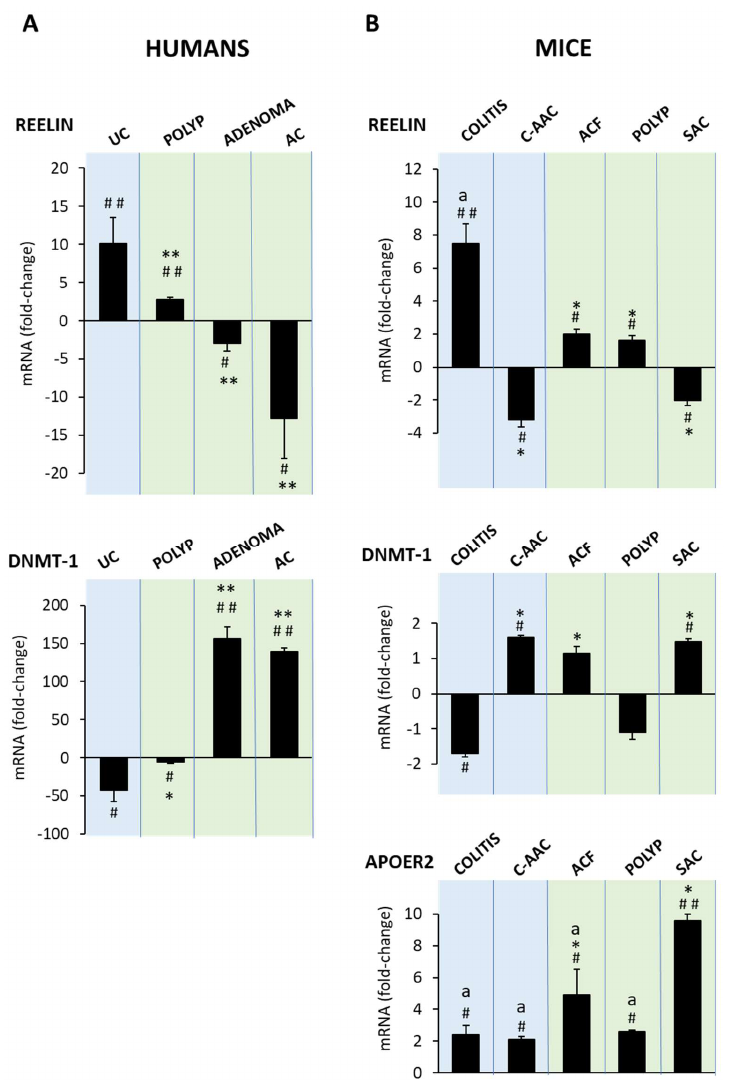
Figure 4. Reelin, DNMT-1 and ApoER2 mRNA abundance in human and mouse colon cancer development. Histograms represent mRNA abundance expressed as fold changes relative to healthy colons. Data are means ± SEM ( n = 8 human or animal samples per condition). ANOVA shows an effect ( p < 0.0001) of colonic disease progression on mRNA reelin, DNMT-1 and ApoER2 abun- dances. ( A ) Human tissue samples: ulcerative colitis (UC), polyp, adenoma, adenocarcinoma (AC). Tukey’s test: # p <0.05; ## p <0.01 vs. healthy colon and * p < 0.01; ** p < 0.001 vs. ulcerative colitis. ( B ) Mouse tissue samples: colitis, colitis-associated adenocarcinoma (C-AAC), aberrant crypt foci (ACF), polyp, sporadic adenocarcinoma (SAC). Tukey’s test: # p < 0.05; ## p < 0.01 vs. healthy colon and * p < 0.001 vs colitis; a p < 0.001 vs. sporadic adenocarcinoma.